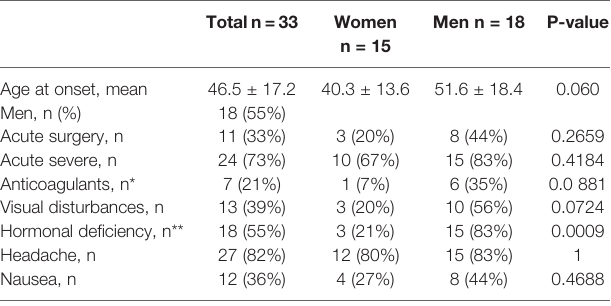
TABLE 1 | Characteristics, presentation and surgery of all consecutive cases of pituitary apoplexy admitted at the Karolinska University Hospital during a 15-year-period.